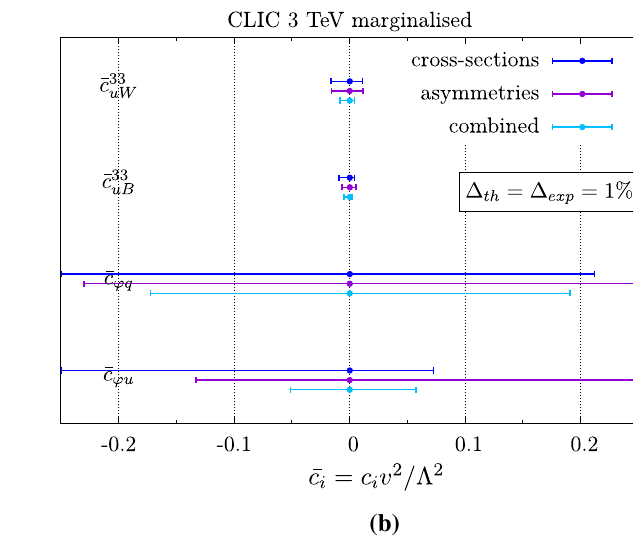
nation, with each operator considered individually ( a ) or in a 5D fit ( b ). To display both on the same plot, we scale the individual constraints up by a factor of 10, so that the bottom axis is actually ¯ c